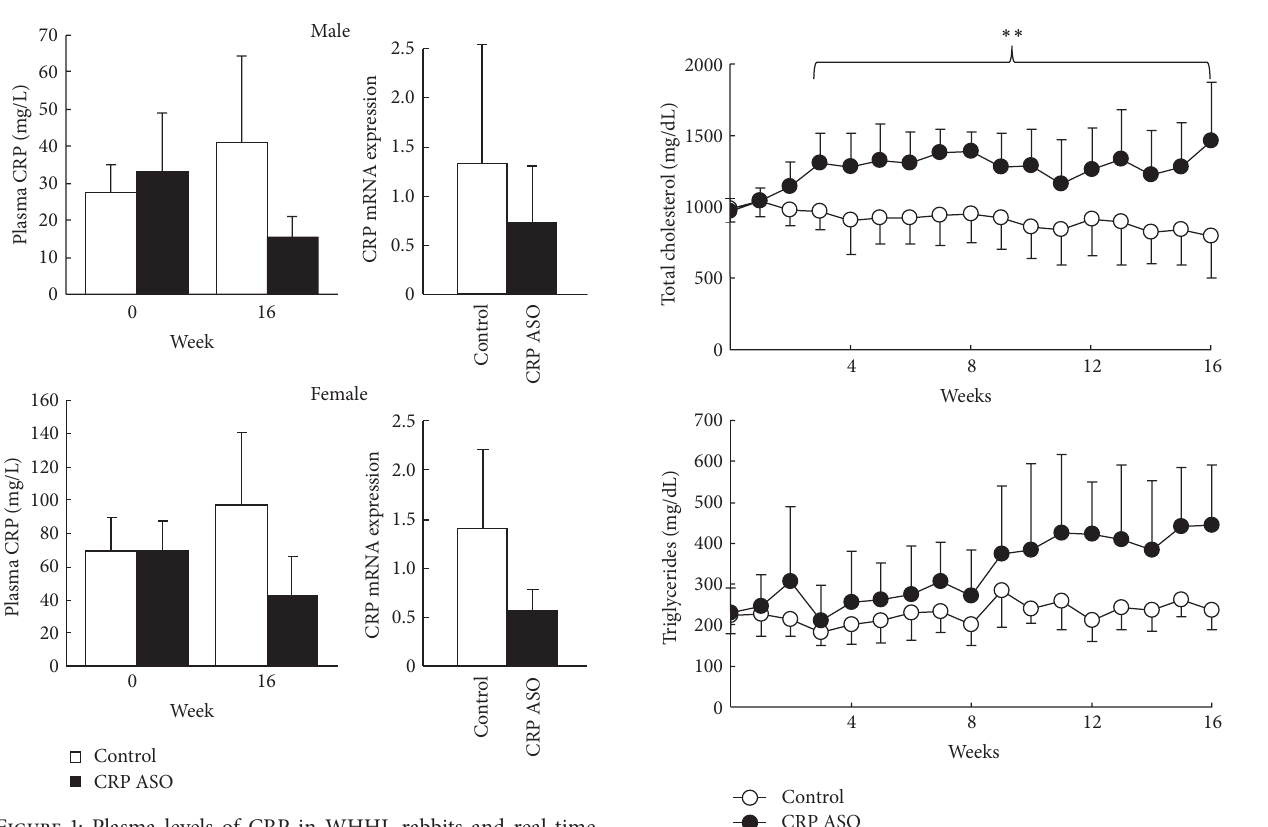
Figure 1: Plasma levels of CRP in WHHL rabbits and real-time RT-PCR analysis of hepatic mRNA of CRP expression. Plasma CRP levels were measured before and after treatment with CRP ASOs for 16 weeks. CRP mRNA expression in the liver was quantified at 16 weeks. The values are expressed as the mean ± SD. 𝑛 = 4 -5 for each group.